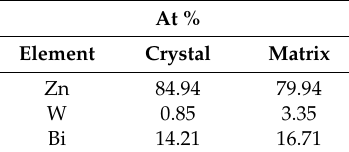
Table 2. EDS results of the glass ceramic as prepared material.